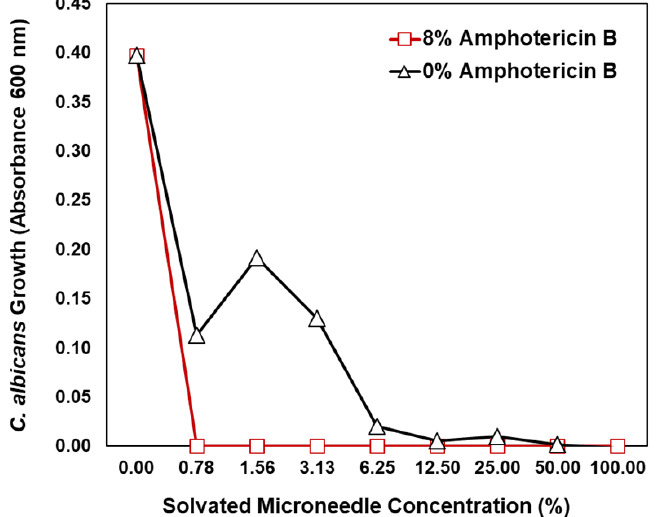
Figure 10. Candida albicans solution growth assessments in nutrient media dilutions of fully solvated microneedles. The 100% concentration denotes microneedle samples solvated in 3 mL of PBS (1×).